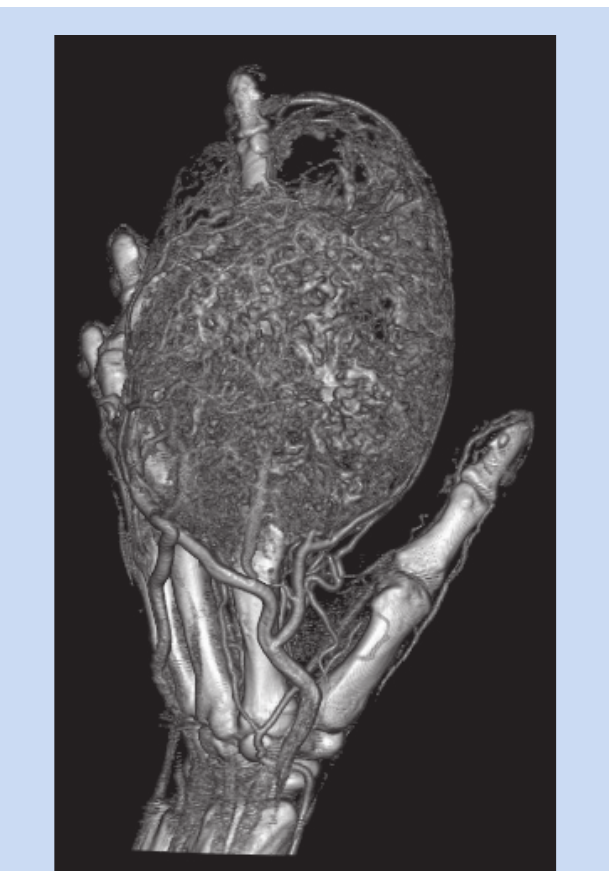
Fig. 3. CT volume-rendered representation of the elaborate vascular supply to the